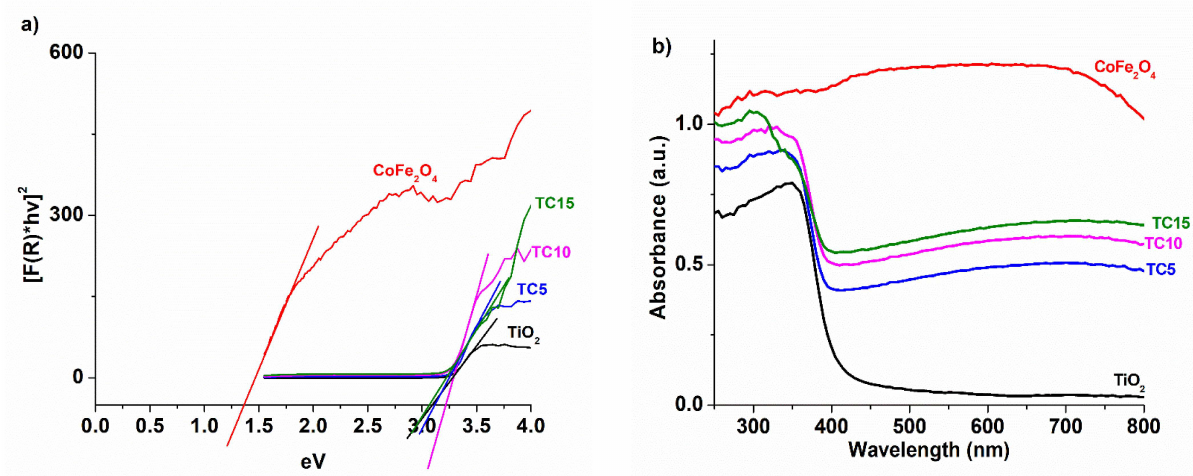
Figure 8. Tauc plots of the prepared photocatalysts ( a ), along with the relevant absorbance spectra ( b